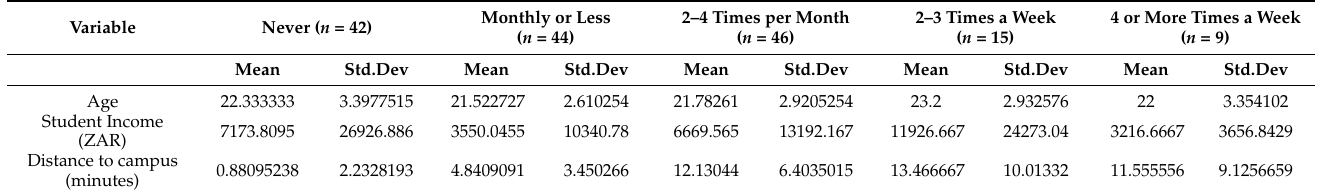
Table 3. Determinants of alcohol consumption of university students for continuous